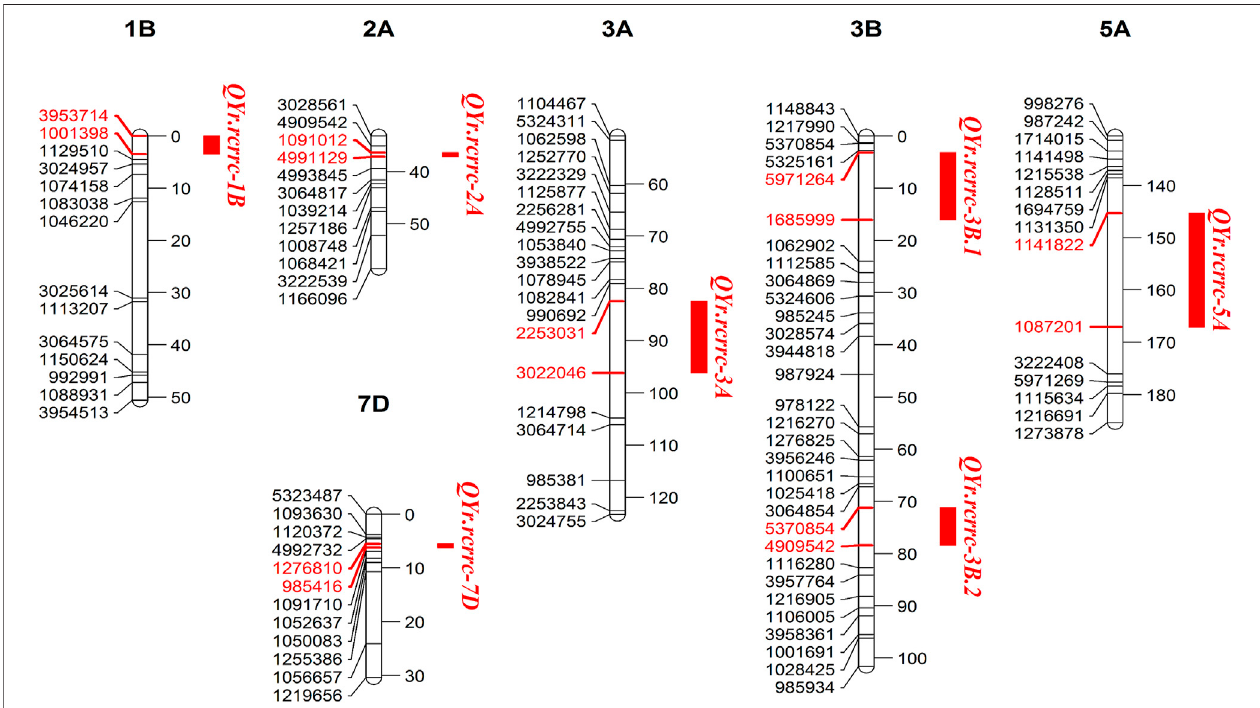
FIGURE 2 | Segments of genetic linkage maps of QTL conferring adult plant stripe rust resistance. Single-nucleotide polymorphism (SNP) markers are shown on theleftandtheirgeneticpositions(cM)areontherightofchromosomes.TheregioncontainingtheQTLisindicatedbyaverticalbarontherightandfollowedbythename of the QTL. The markers in red are associated with the